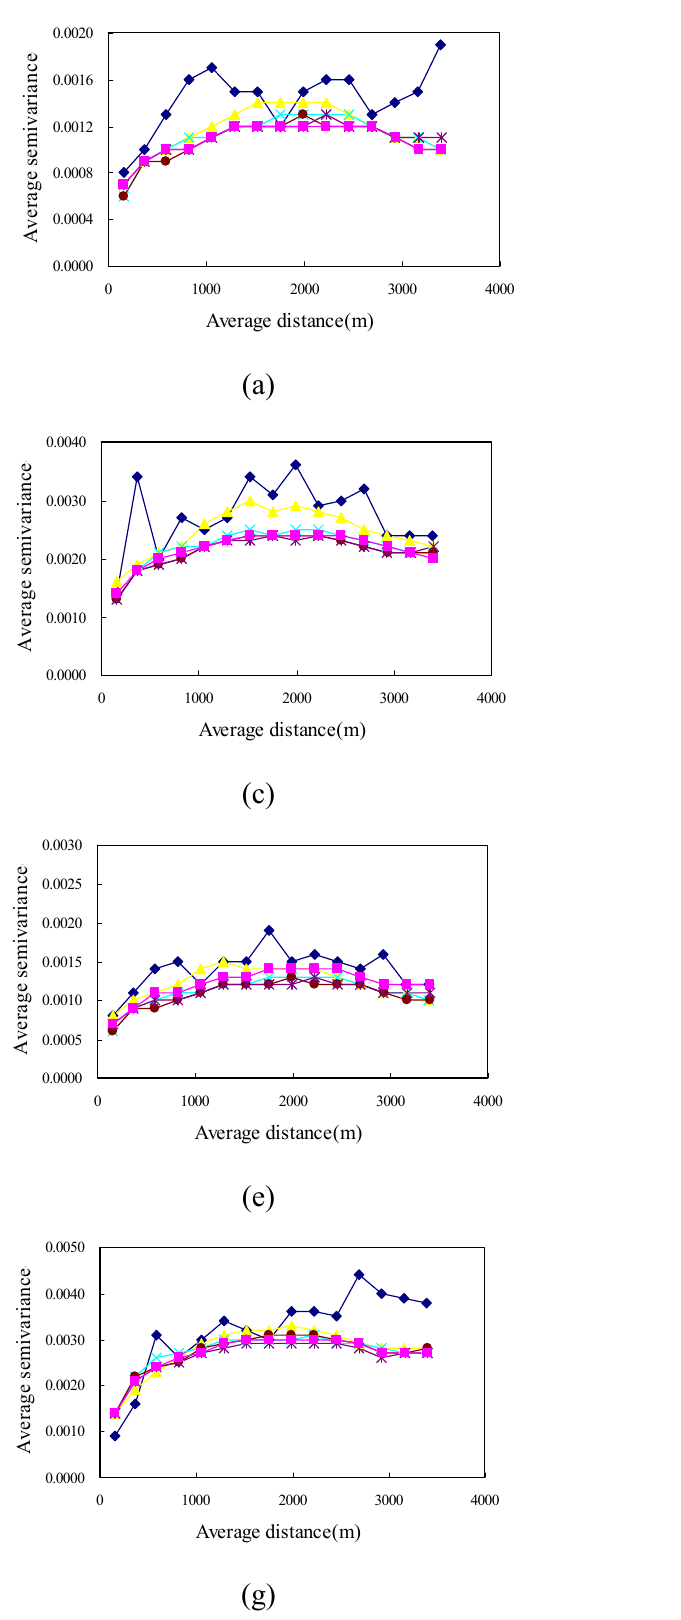
Figure 5. Experimental variograms of NDVI samples for area A on (a) 1996/11/08, (b) 1999/03/06, (c) 1999/10/31, (d) 2000/11/27, (e) 2001/11/20 (f) 2003/12/17, and (g)